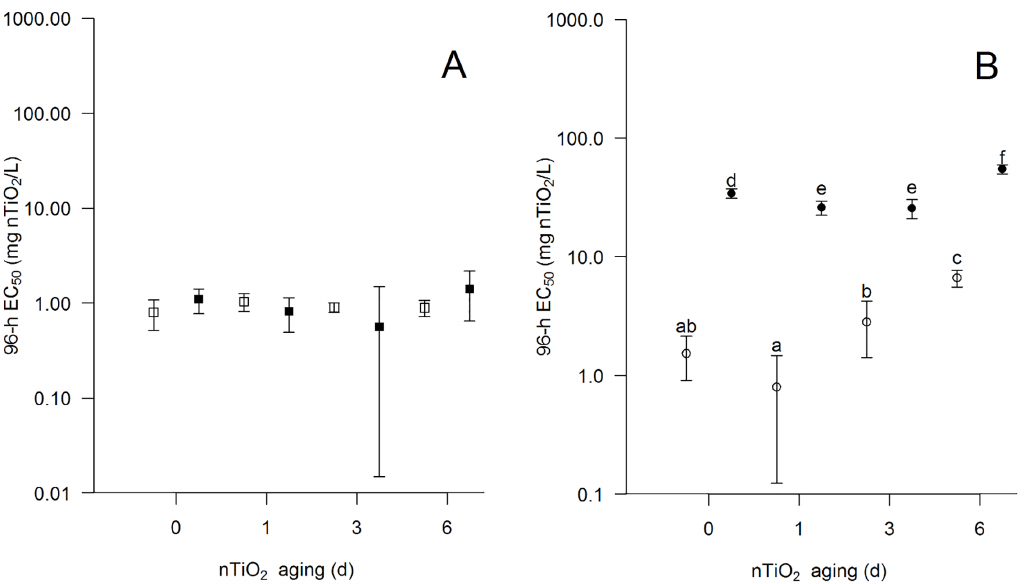
Fig 1. Acute toxicity of aged nTiO2. (A) 96-h EC50 values (half maximal effective concentration; ± 95% CI) of nTiO2 aged for 0, 1, 3 or 6 d in Milli-Q with ( & ) or without ( □ ) NOM. (B) 96-h EC50 values ( ± 95% CI) of nTiO2 previously aged for 0, 1, 3 or 6 d in ASTM with ( ● ) and without ( (cid:1) ) NOM. 96-h EC50 values followed by different lower case letters are significantly